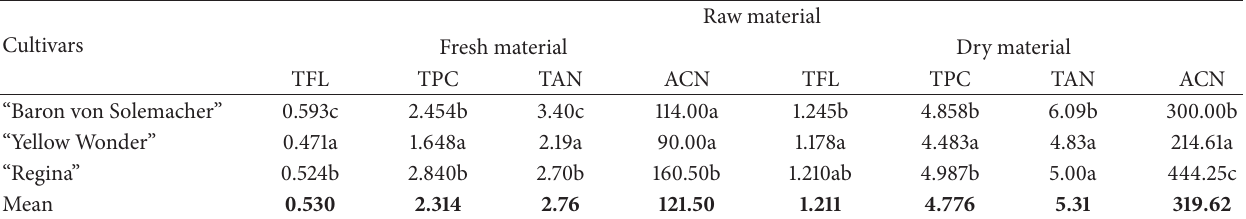
Table 3: Content of flavonoids TFL (as quercetin) mg ⋅ g −1 , phenolic acids TPC (as caffeic acid) mg ⋅ g −1 , tannins (%), and anthocyanins ACN (as delphinidin mg ⋅ 100g −1 ) in raw material. Cultivars